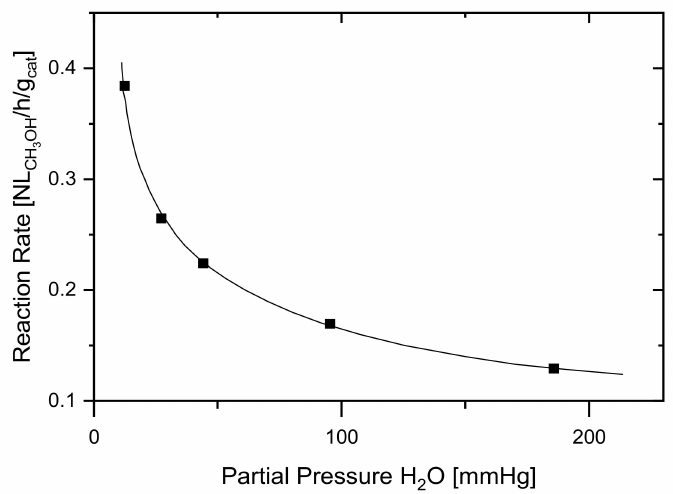
Figure 8. Influence of H 2 O partial pressure on the rate of MeOH oxidation. T = 232 ◦ C; P tot = 920 mmHg; P O = 180 mmHg; P CH = 180 mmHg. Reproduced from [50] Copyright © 2 3 OH (1968) with permission from